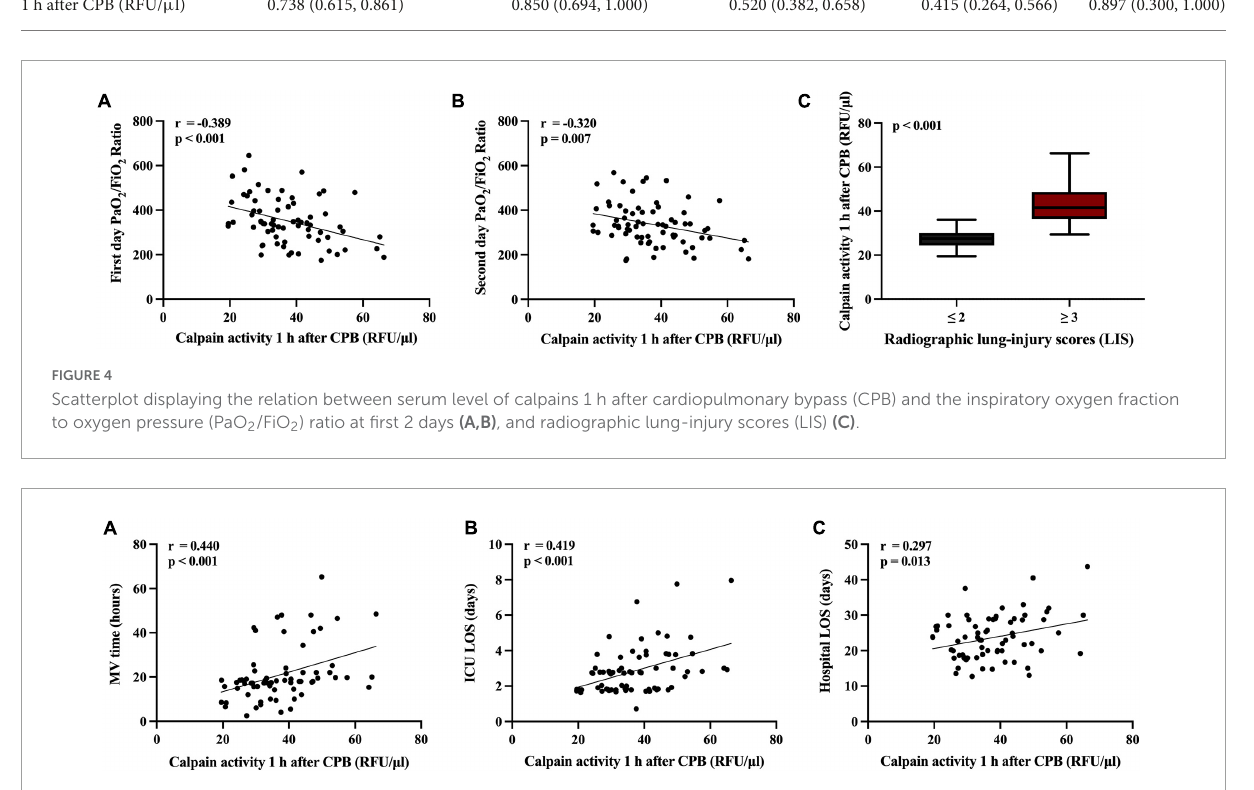
FIGURE5 Scatterplot displaying the relation between serum level of calpains 1 h after cardiopulmonary bypass (CPB) and the clinical outcomes. The mechanical ventilation time (A) , the intensive care unit (ICU) length of stay (LOS) (B) , and the hospital LOS (C) are